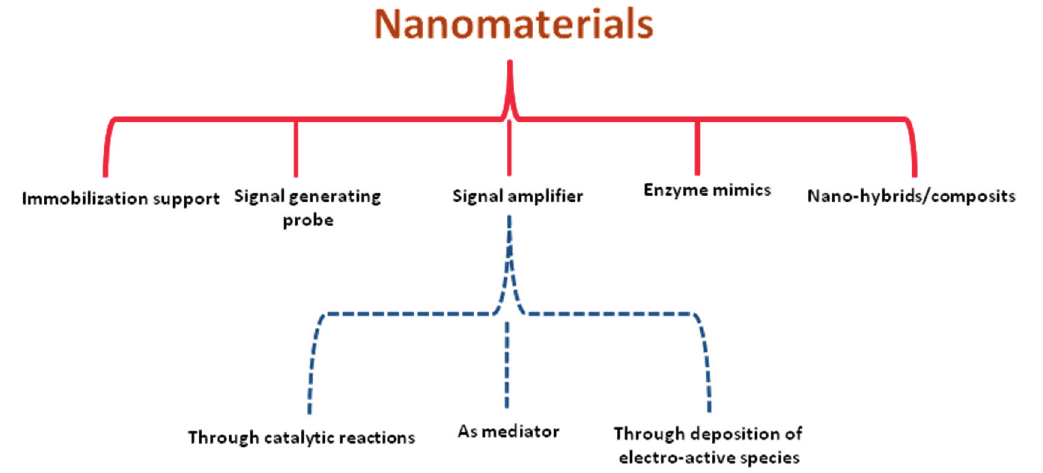
Figure 1. Possible functions that can be achieved with nanomaterial integration in amperometric